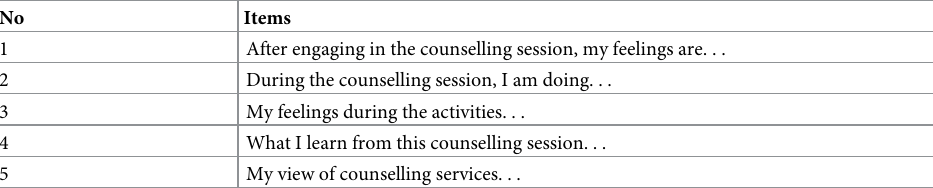
Table 3. Prepared and open-ended statements for diary writing. No Items 1 After engaging in the counselling session, my feelings are. . . 2 During the counselling session, I am doing. . . 3 My feelings during the activities. . . 4 What I learn from this counselling session. . . 5 My view of counselling services. . .